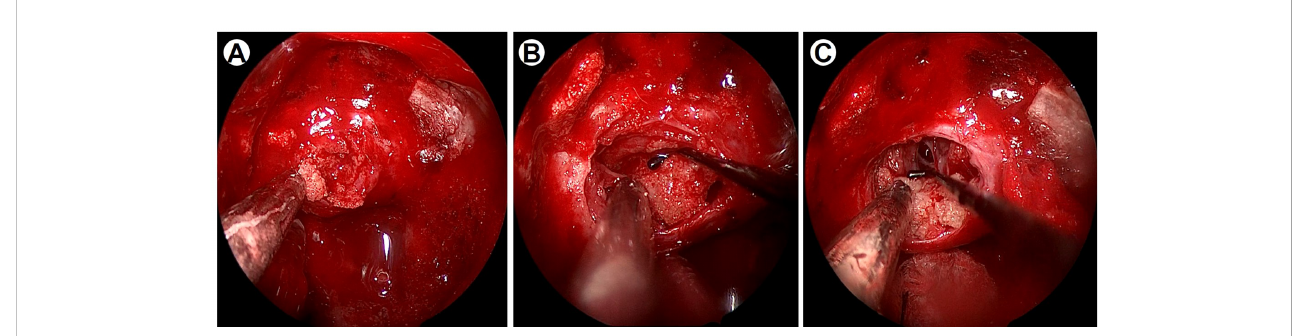
FIGURE 2 Intraoperative imaging data under neuroendoscopy. (A) Intraoperative imaging indicates the yellowish tumor was fi rm and consisted of psammoma bodies. (B) The lesion adhered closely to the diaphragma sellae. (C) After the tumor removal, the diaphragma sellae was broken and cerebrospinal fl uid leakage was observed.